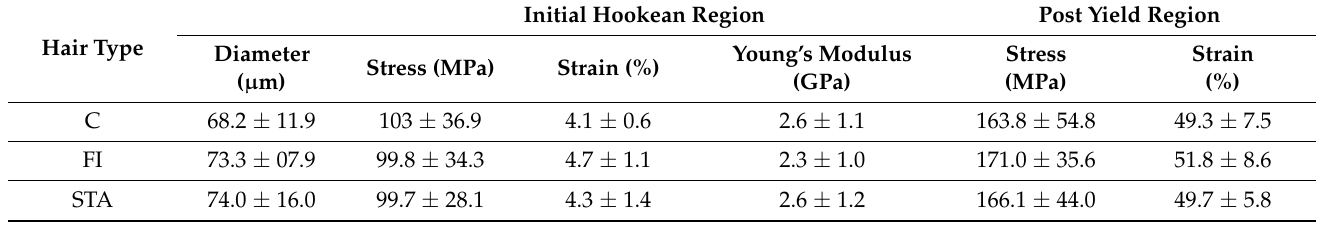
Figure 5. Typical stress–strain plots for C, FI, and STA hair. Table 1. Tensile properties of the C, FI, and STA hair.